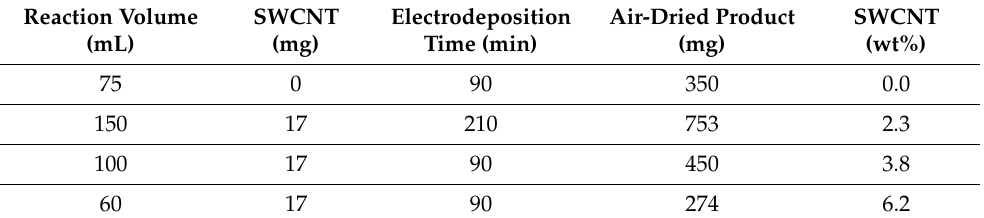
Table 1. Composition of electrolysis bath, electrodeposition time, and yield of